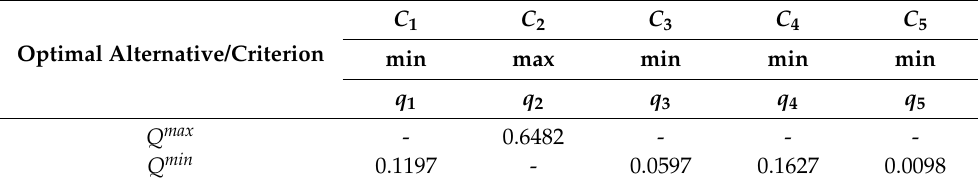
Table 14 represents the decomposition of the optimal alternative. Table 14. Decomposition of the optimal alternative.